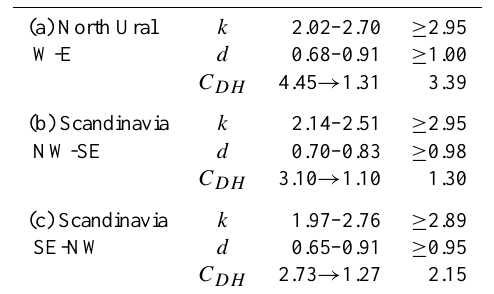
Table 1. The ranges of k and d in which the flow is statically unsta- ble, with the corresponding bound values of drag coefficient.